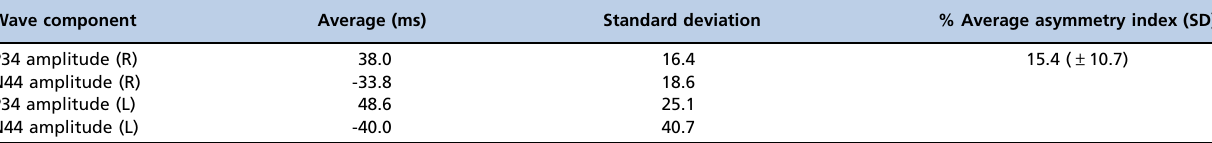
R: Right side, L: Left